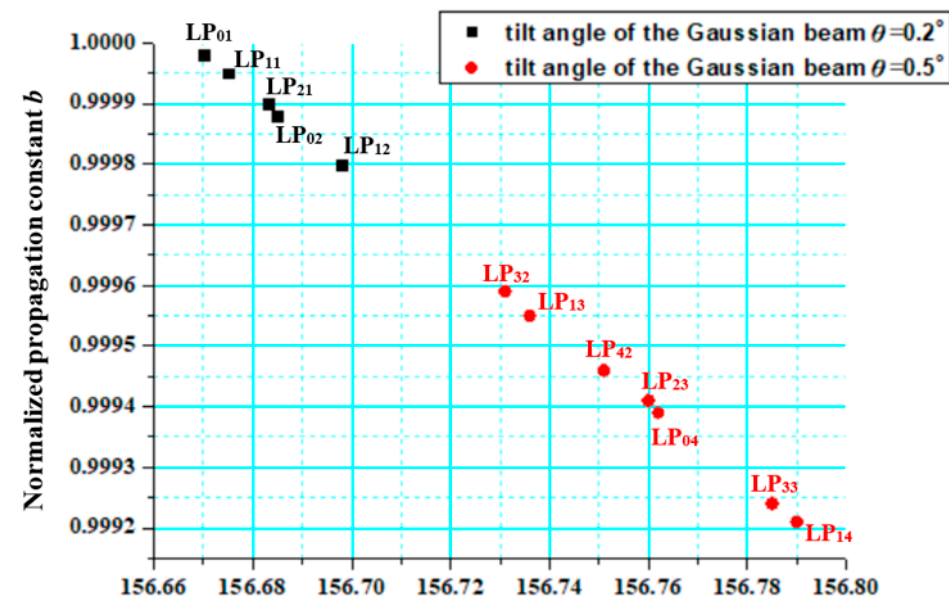
Figure 2. The normalized propagation constant b varies with the group delay time of excitation modes per unit length of fiber for the tilt angle θ = 0.2° and 0.5 of the Gaussian beams.